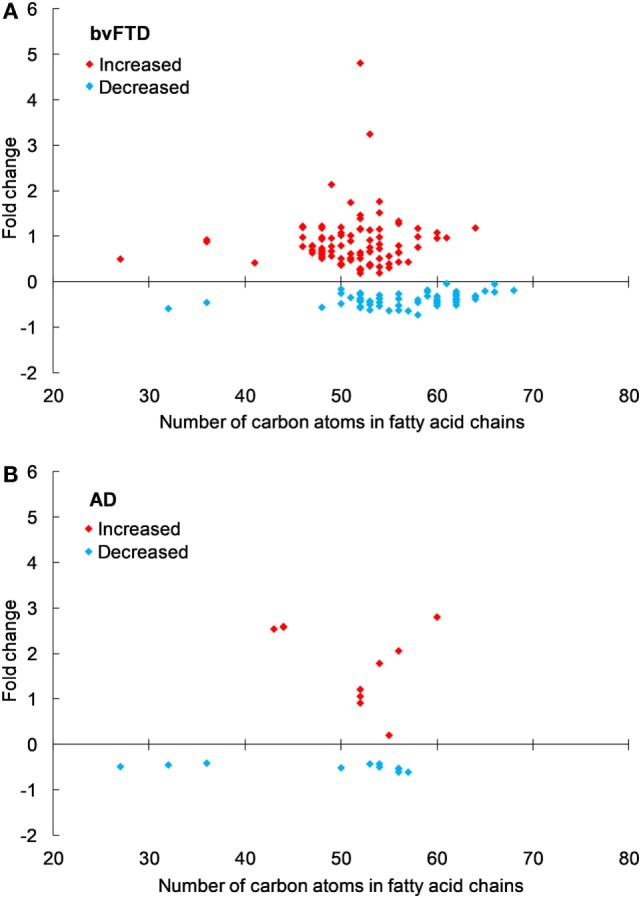
Triglyceride species that were significantly altered in (A) behavioral variant frontotemporal dementia (bvFTD) and (B) Alzheimer’s disease (AD) compared to control. Each symbol represents a lipid species with different number of carbon atoms in fatty acid chains; red symbols are those that are significantly increased and blue symbols significantly decreased; p < 0.05. The data presented are fold changes on linear scale. Zero represents no change; 0.5 fold change represents 50% increase; and −0.5 represents 50% decrease.